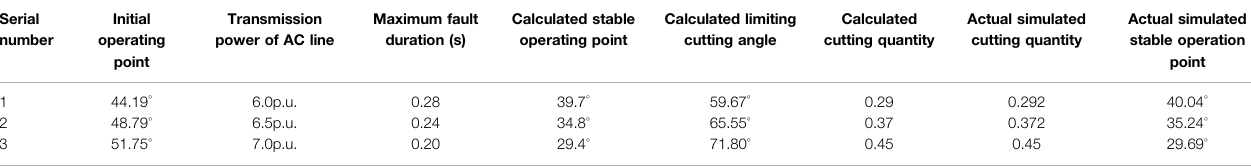
TABLE 2 | Calculation and simulation results of generator tripping and load shedding of sending and receiving AC power systems with different operation